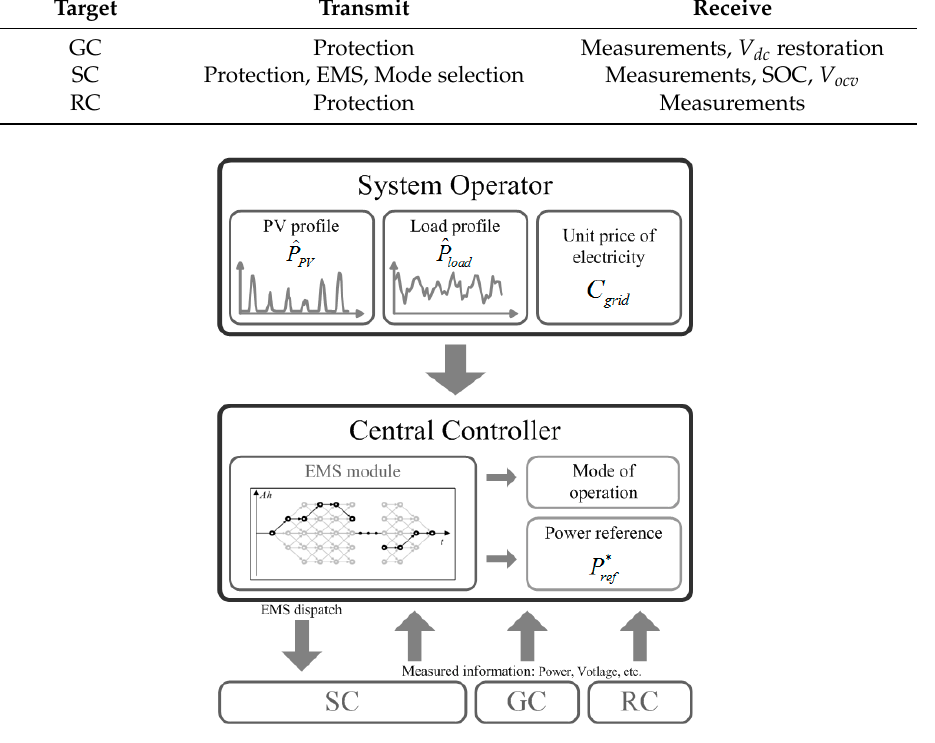
Figure 4. V – I curves and the operating points at State 111.